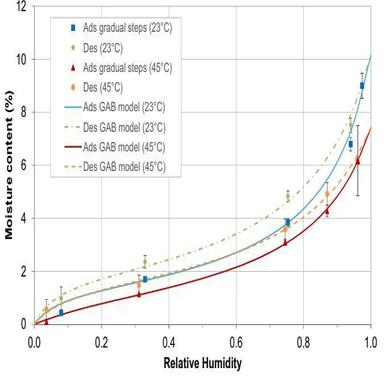
Adsorption (Ads) and desorption (Des) at 23 °C and 45 °C, experimental data and GAB model.